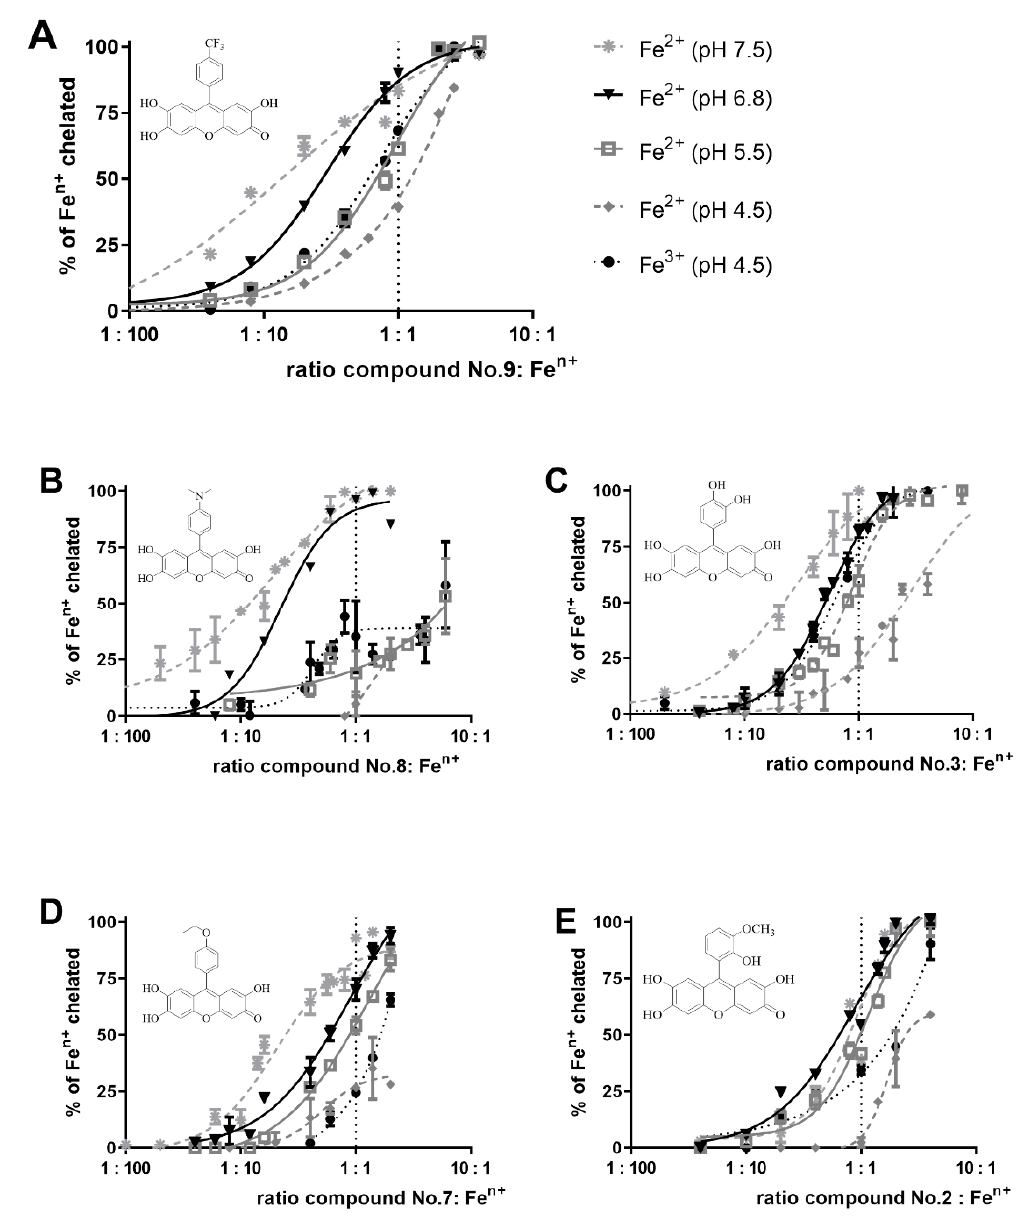
Figure 2. Iron chelation by representative compounds. A : 4′-trifluoromethyl ( 9 ), B : 4′-dimethylamino ( 8 ), C : 4′-ethoxy ( 7 ), D : 3′,4′-dihydroxy ( 3 ) and E : 2′-hydroxy-3′-methoxy ( 2 ). The graphs show different xanthone:iron ions ratios at different pH conditions. The percentage of chelation on the y axis was calculated using the positive control sample (solvent with iron ions—100% remaining metal ions and hence 0% chelation). The final concentration of the iron ions was 50 µM in all cases.